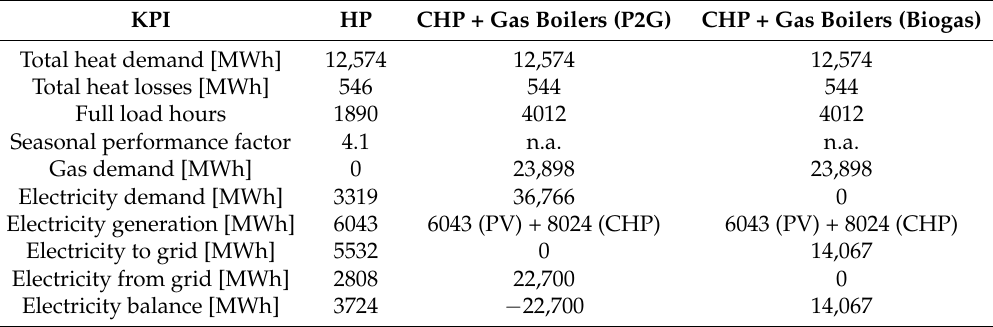
Table 2. Key performance indicators (KPI) for both